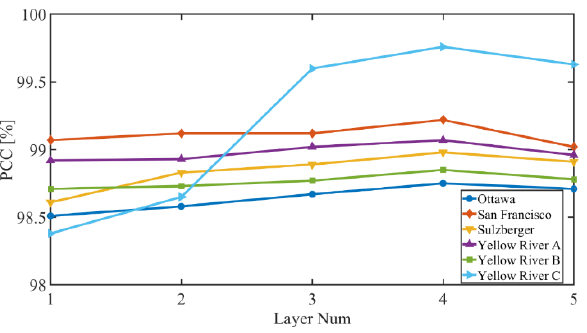
Figure 17. The PCC values with different numbers of PCBA blocks. Furthermore, spatial context information is related to the size of input